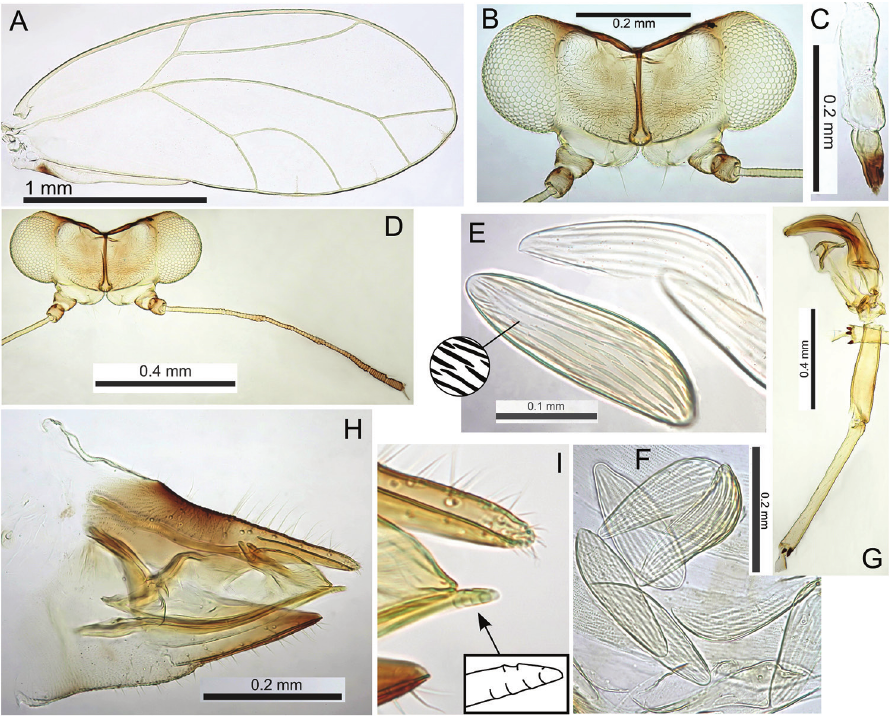
Figure 29. Pariaconus gagneae sp. n. (female) A fore wing B head C proboscis D head and antenna E, F eggs (striations indicated) G hind leg H female terminalia I ovipositor (serrations indicated). Host plant notes. Morphotype preference unknown.